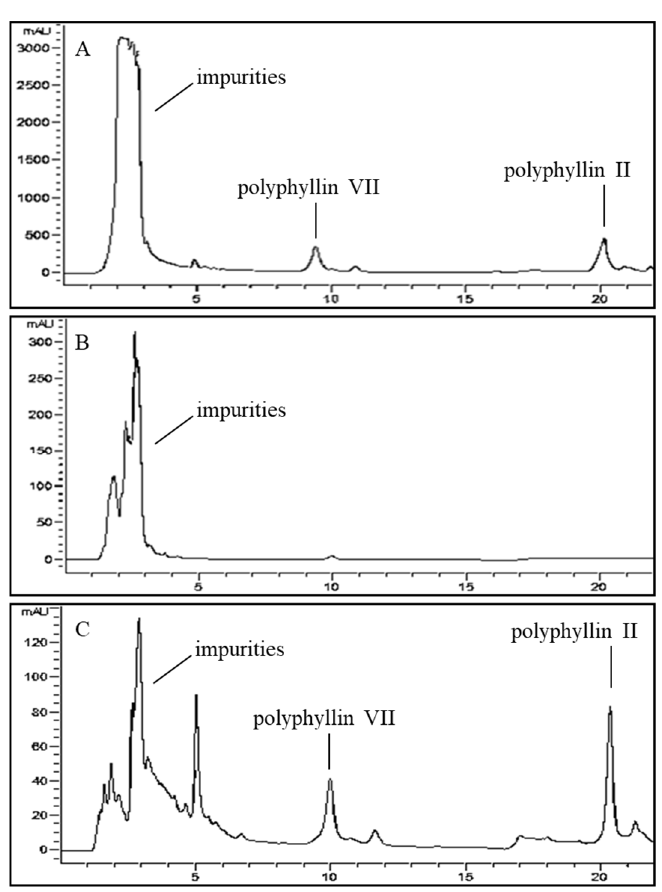
Figure 11. HPLC chromatograms of the samples: Sample solution before treatment ( A ); Samples eluted by 20% ethanol ( B ); Sample solution after treatment with the NKA-9 resin ( C ).